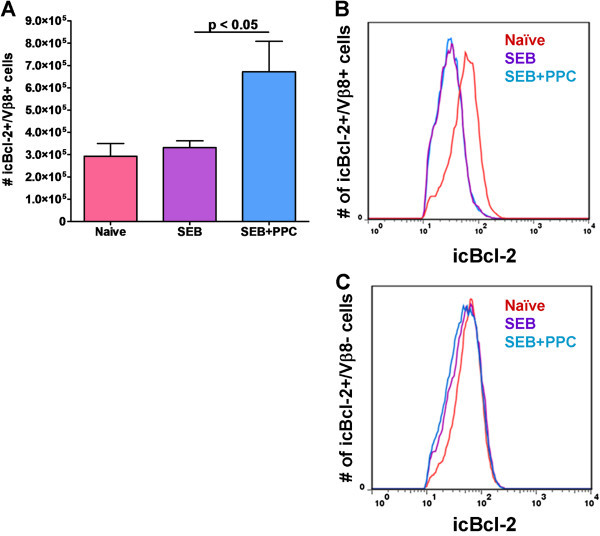
Intracellular levels of Bcl-2 in Vβ8+ lymph node T cells 48 h post SEB injection. Balb/c mice (n = 3 per group) were treated as described in the Materials and Methods. The number of intracellular Bcl-2+/Vβ8+ lymph node T cells from the Naive (red line), SEB (purple line), and SEB + PPC groups (blue line) are shown in the bar graph (panel A) and the histogram in panel B. Error bars in panel A represent standard deviation. The histogram in panel C depicts the number of intracellular Bcl-2+/Vβ8- cells detected in the lymph nodes from the different treatment groups.